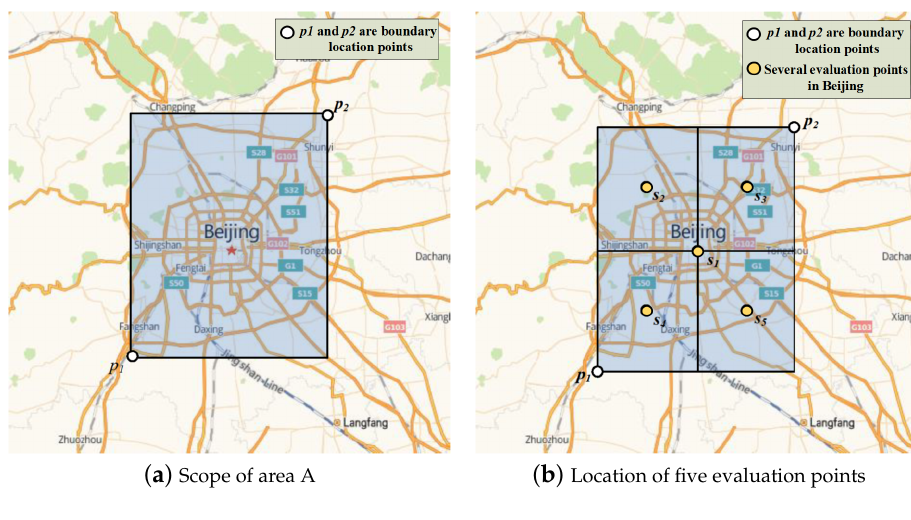
Figure 6. Area A and